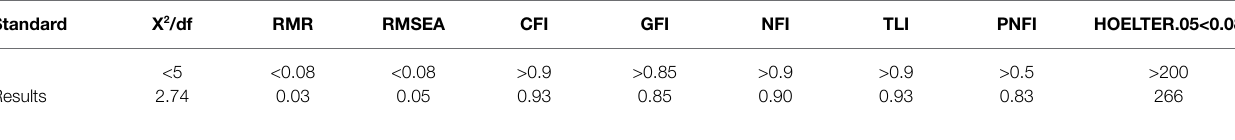
TABLE 1 | Model fit indices.